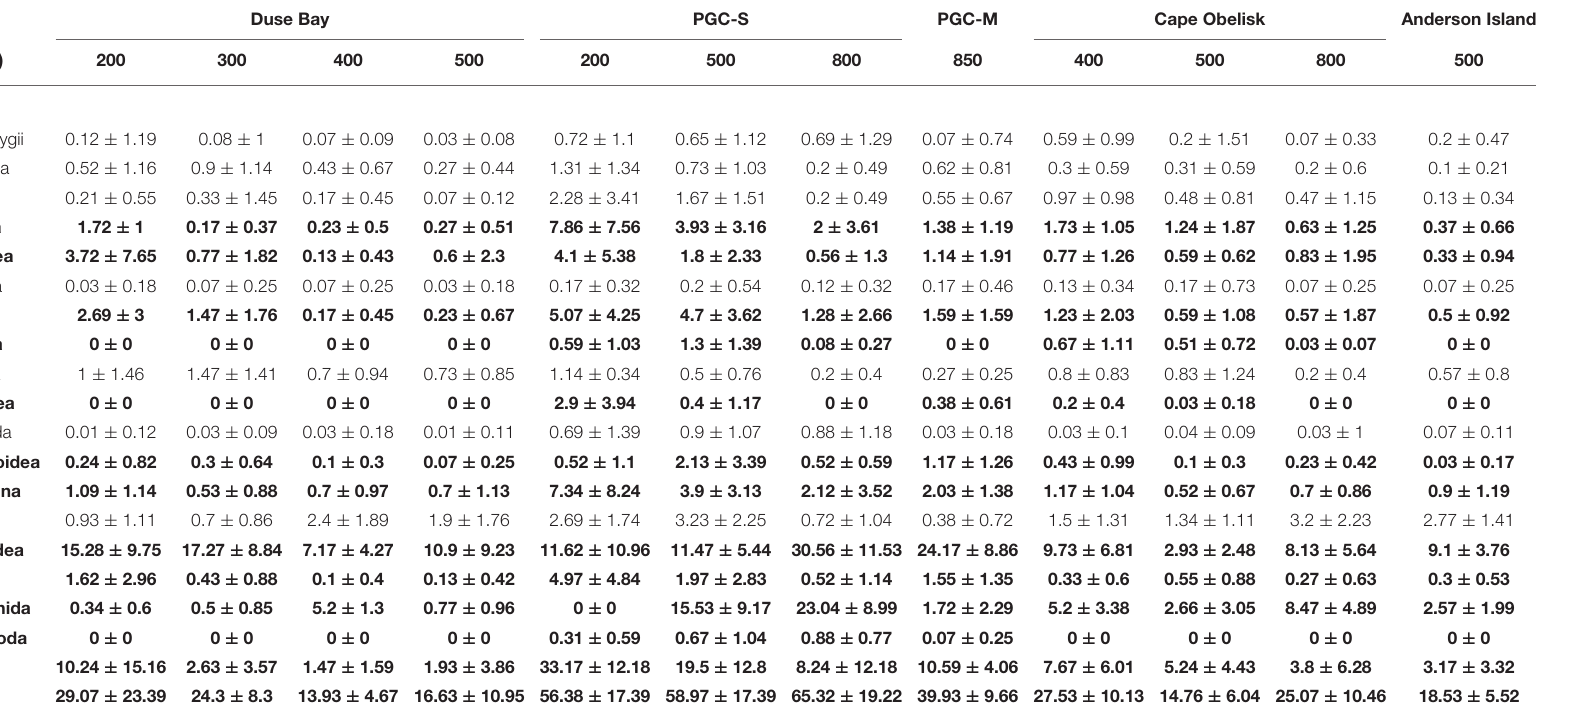
TABLE 4 | Mean number of individuals identified at each location in the Prince Gustav